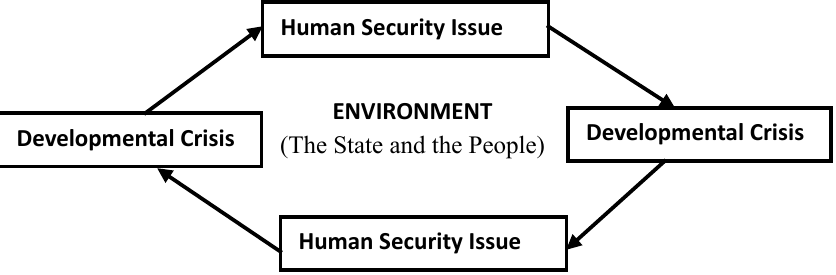
Figure 2. Interchange between human security and developmental